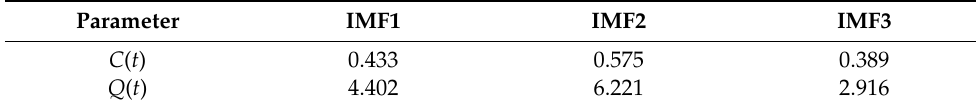
Figure 11. EEMD decomposition result. Table 1. Index values of different IMF signal components (VMD).